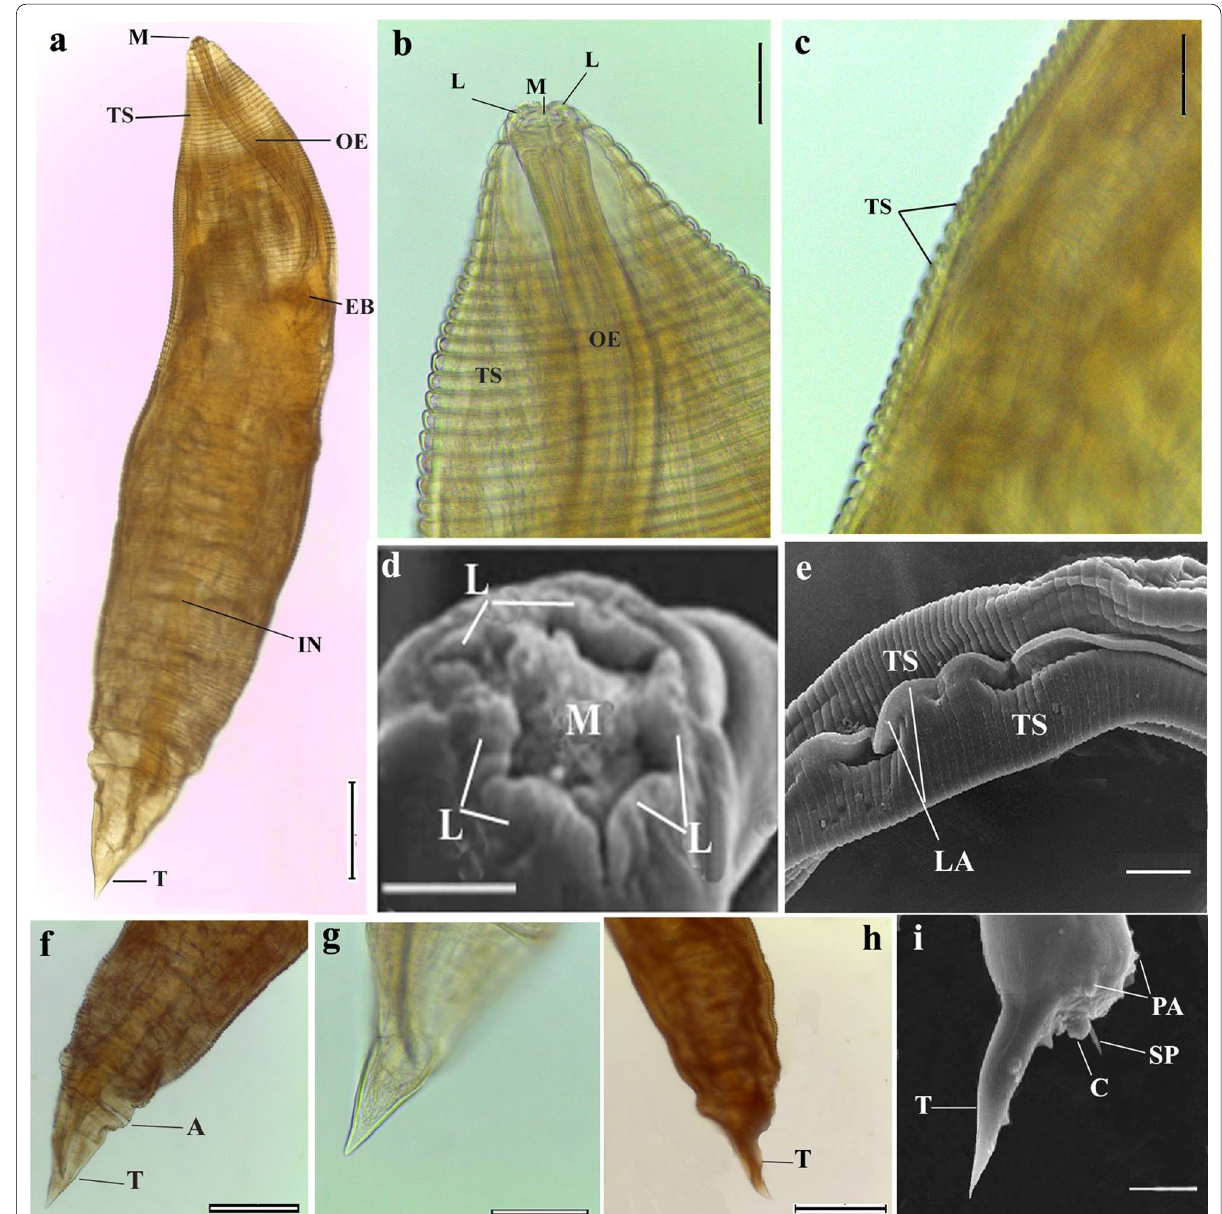
Fig. 1 a – c , f – h Photomicrograph of T. chalcidiae showing a Whole worm with mouth (M) followed by esophagus (OE) with esophageal bulb (EB) lead to long intestine (IN), cuticle with transverse striations (TS), scale bar 200 µm. b Anterior extremity showing mouth (M), lips (L), esophagus = (OE) and transverse striations (TS), scale bar 50 µm. c High magnification showing cuticle with transverse striations (TS), scale bar = f Posterior extremity of female worm with tapered tail (T), anus (A), scale bars 200 µm. g High magnifications of female tail region, scale = bars 50 µm h Posterior extremity of male worm with tail (T), scale bars 200 µm. d , e , i Scanning electron micrographs of T. chalcidiae d Cephalic = = region showing mouth (M) with six lips (L), scale bar 50 µm. e Midbody showing transverse striation (TS) and lateral alae (LA), scale bar = Truncated posterior extremity of male worm with pointed tail (T), single spicule (SP), caudal papillae (PA) and cloaca (C) scale bar